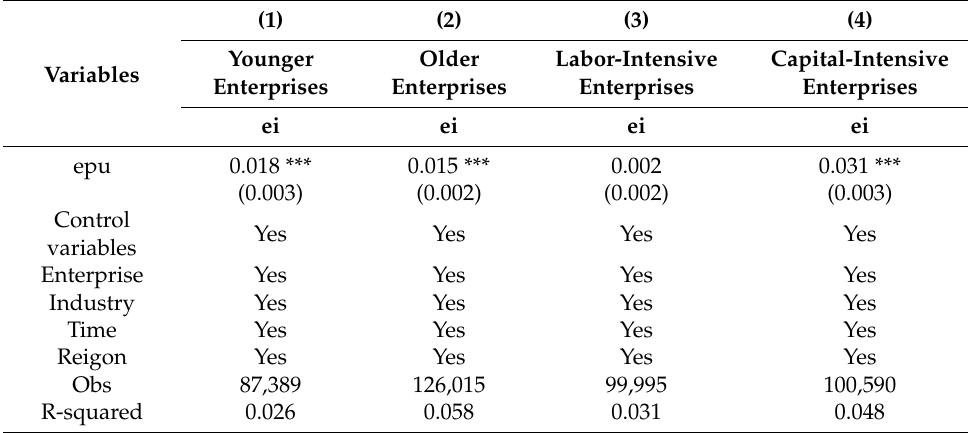
Table 4. Results of enterprise age and type